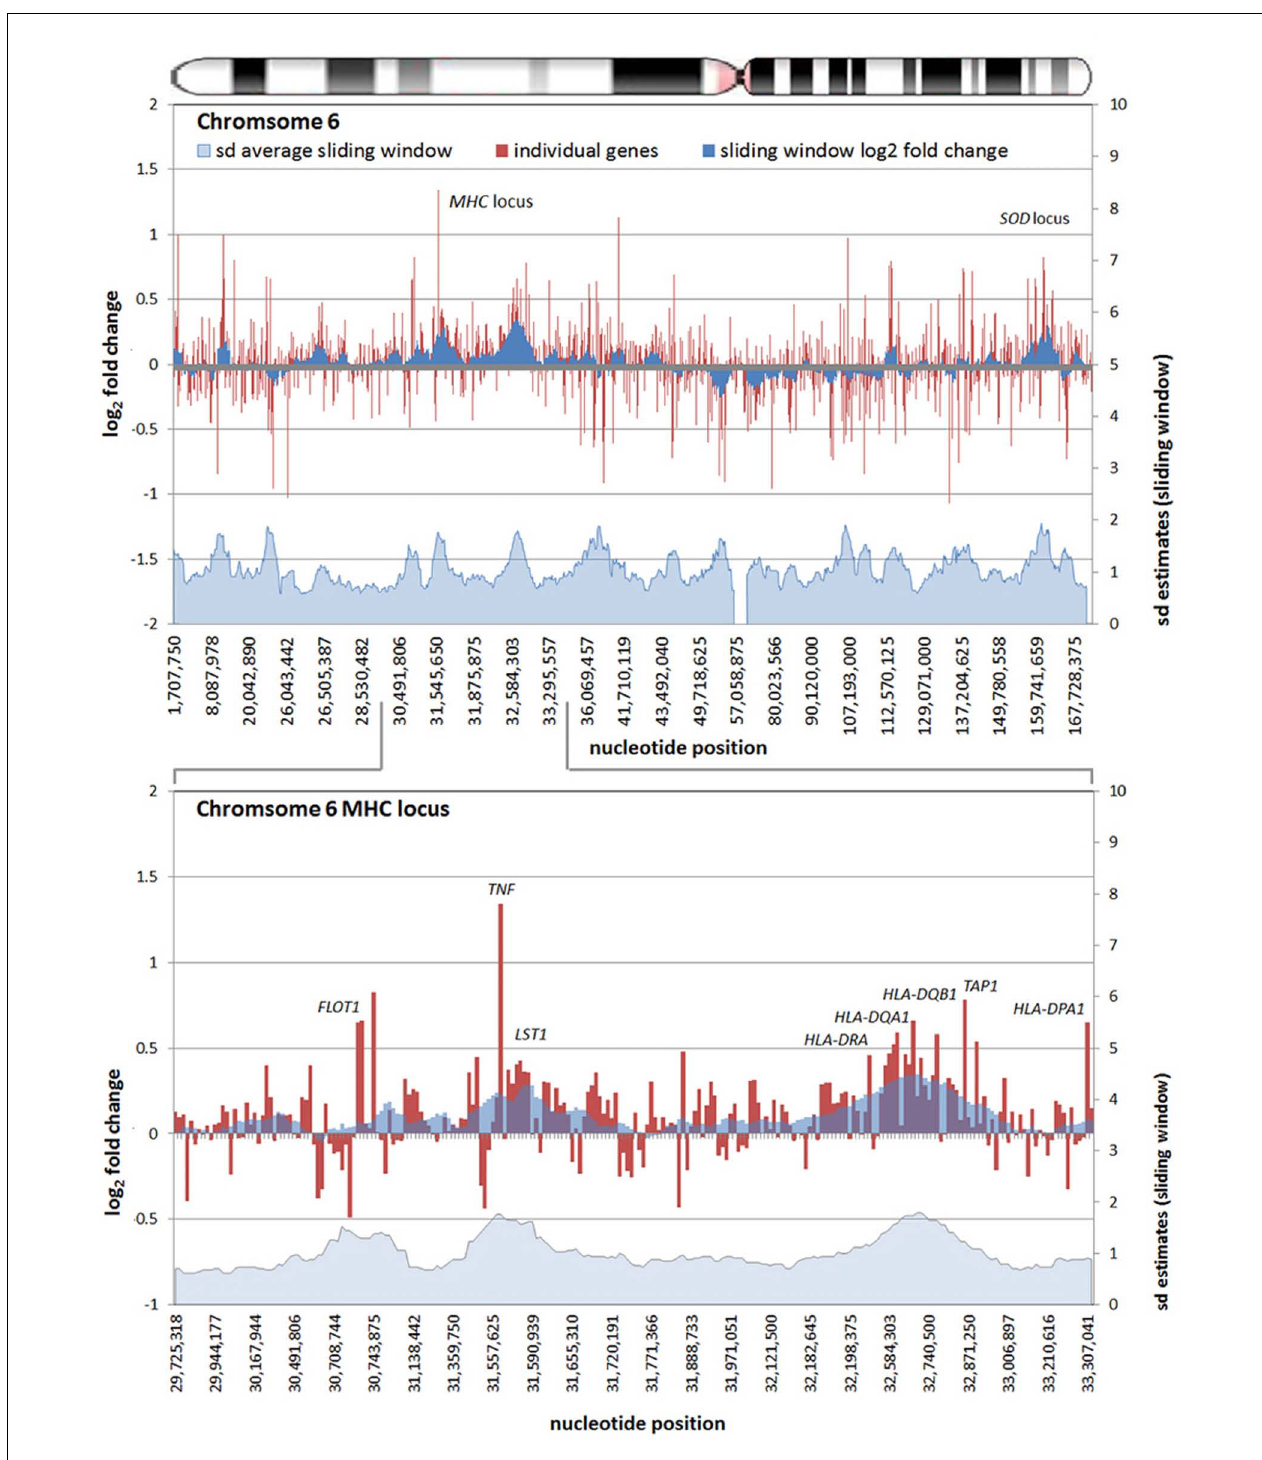
FIGURE 4 | Differential gene expression patterns comparing A. phagocytophilum -infected vs. non-infected human peripheral blood neutrophils are clustered over large linear genomic regions. The top panel shows human chromosome 6; the bottom panel shows the MHC locus on human chromosome 6 including a large genomic region spanning the TNF and HLAD loci that are upregulated with infection.The chromosome ideogram is shown at the top. Red bars (left axes) represent differential